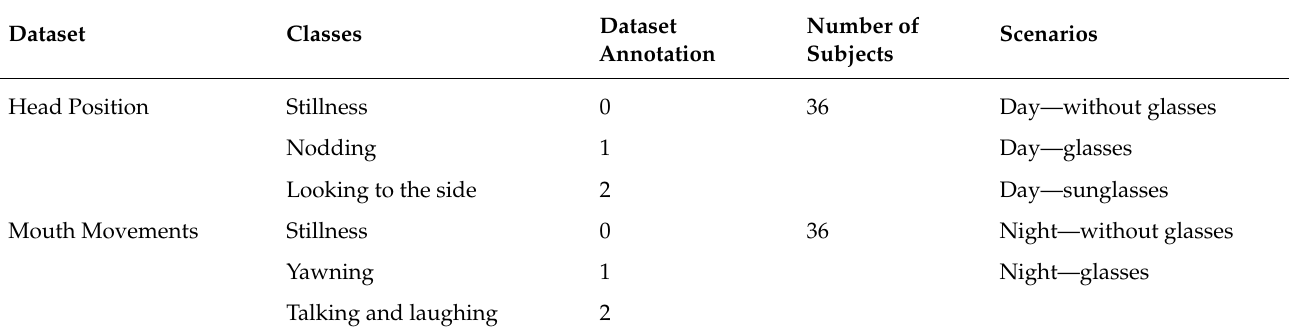
Table 4. Representation of the dataset used.